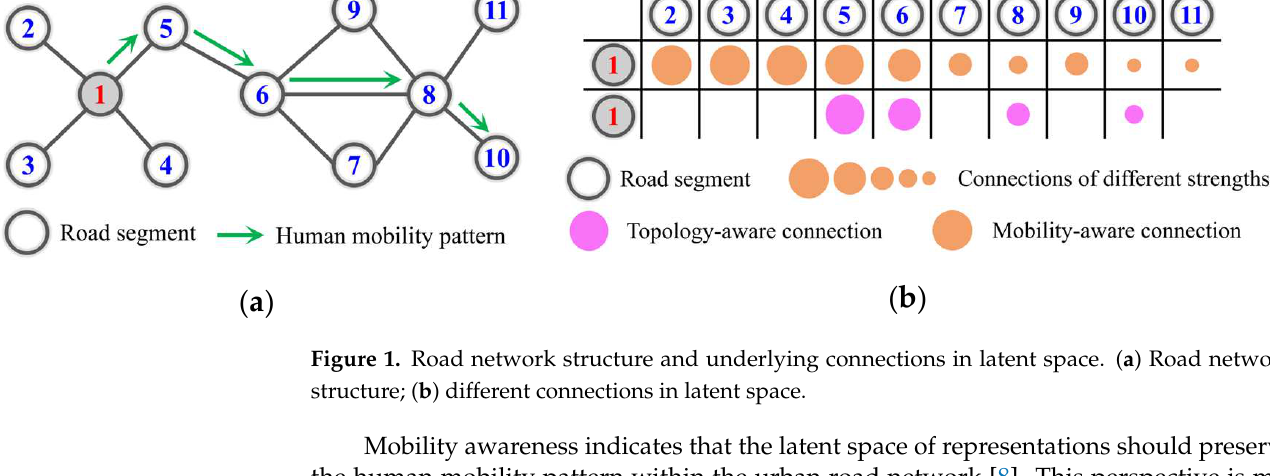
Figure 1a, road segments (cid:193) , (cid:194) , (cid:195) and (cid:196) are the topological neighborhoods of road segment (cid:192) , so their connections are stronger in latent space (Figure 1b).